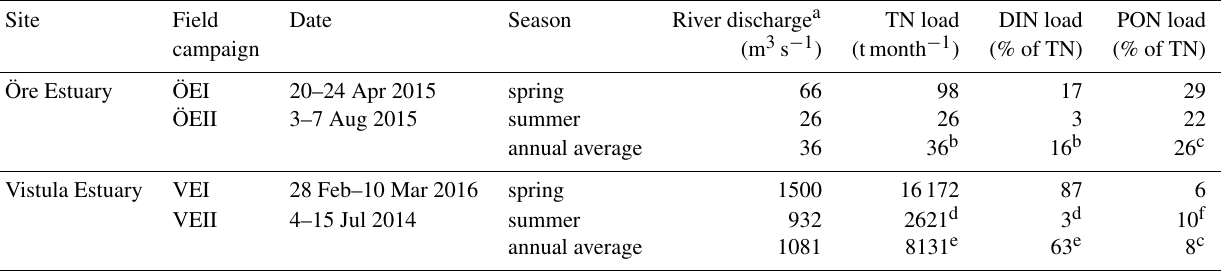
Table 1. Sampling details of the field campaigns, as well as river discharge and N loads during the sampling months, and the annual average.